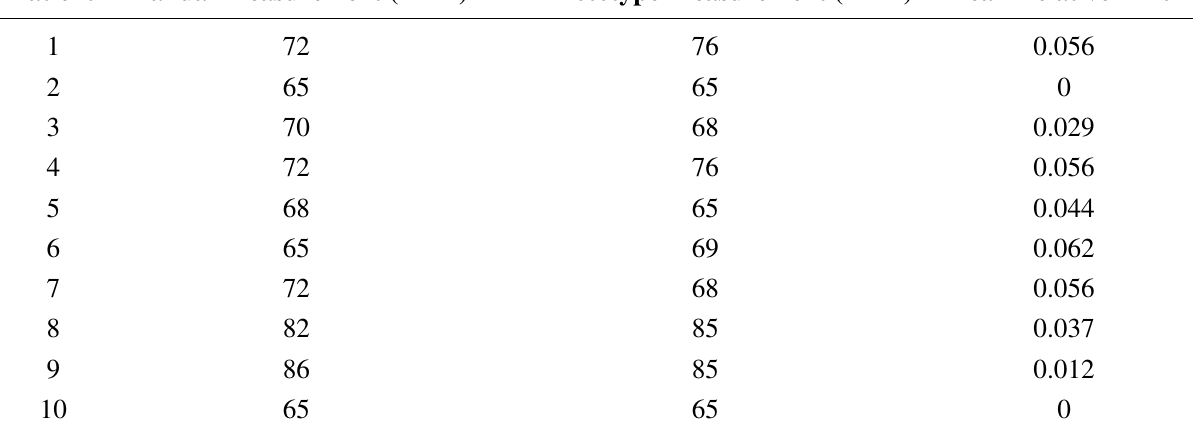
Table 3. Comparative trials between the HR prototype and a conventional digital watch.